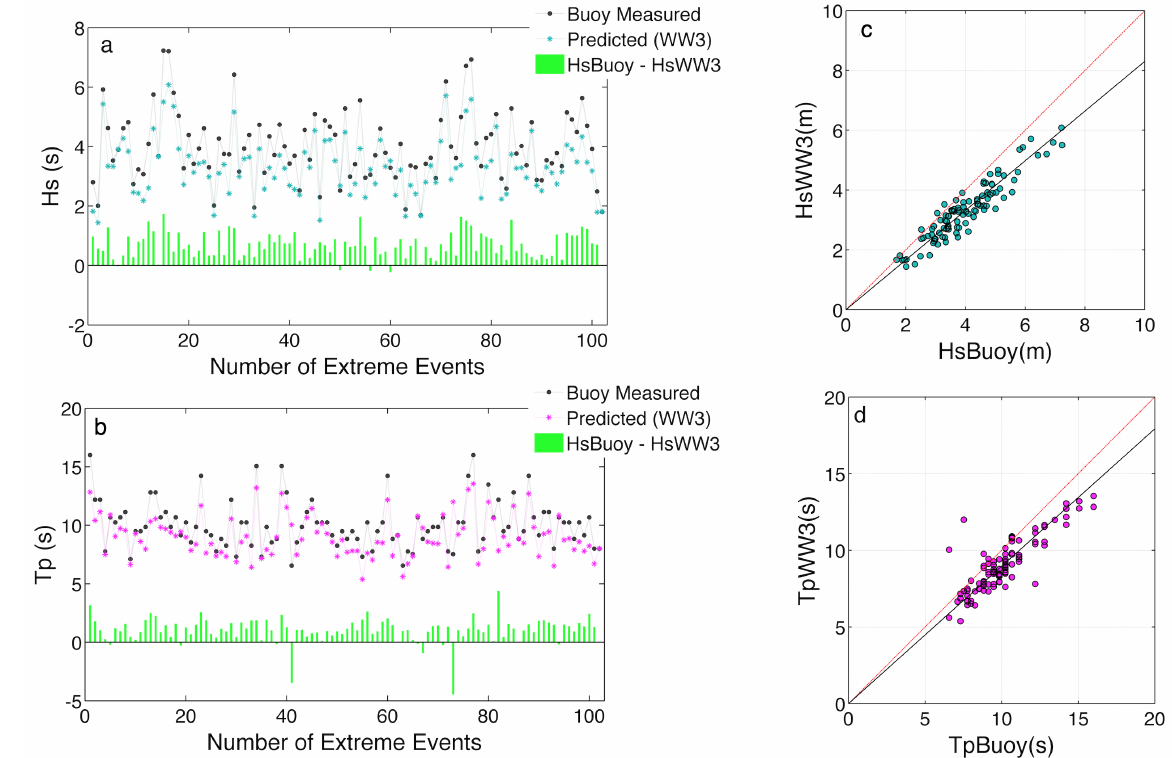
Figure 5. Buoy x Model. Figure (a) and (b) the blue/pink and black dots indicated the 102 extreme cases predicted by WW3 and measured by Minuano buoy respectively, and the green bars are the difference between parameters measured and predicted. In the (c) and (d) represent the scatterplot between parameters (Hs and Tp) modeled x measured for the extreme events in the analysis Buoy x